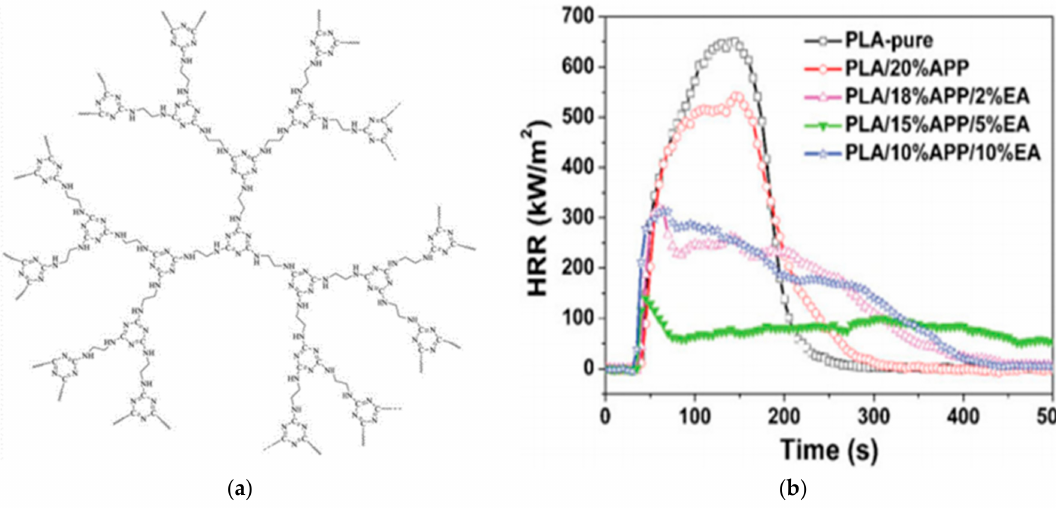
Figure 9. ( a ) Hyperbranched derivative of triazine (EA) and ( b ) PHRR /PLA/APP/EA (Adapted with permission from [117]).